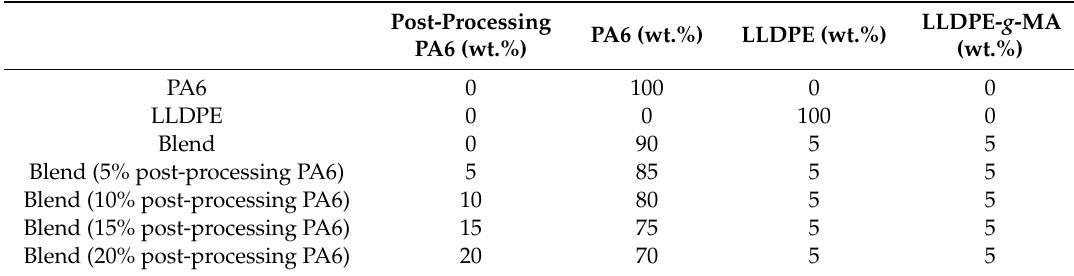
Table 1. Compositions of the PA6 / LLDPE / LLDPE- g -MA blends studied.